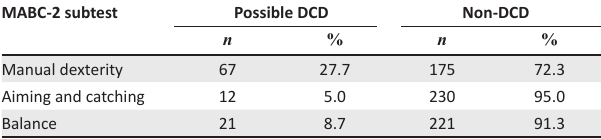
TABLE 4: Distribution of the total group of learners ( N = 242) without and with possible developmental coordination disorder within the three Movement Assessment Battery for Children-2nd edition